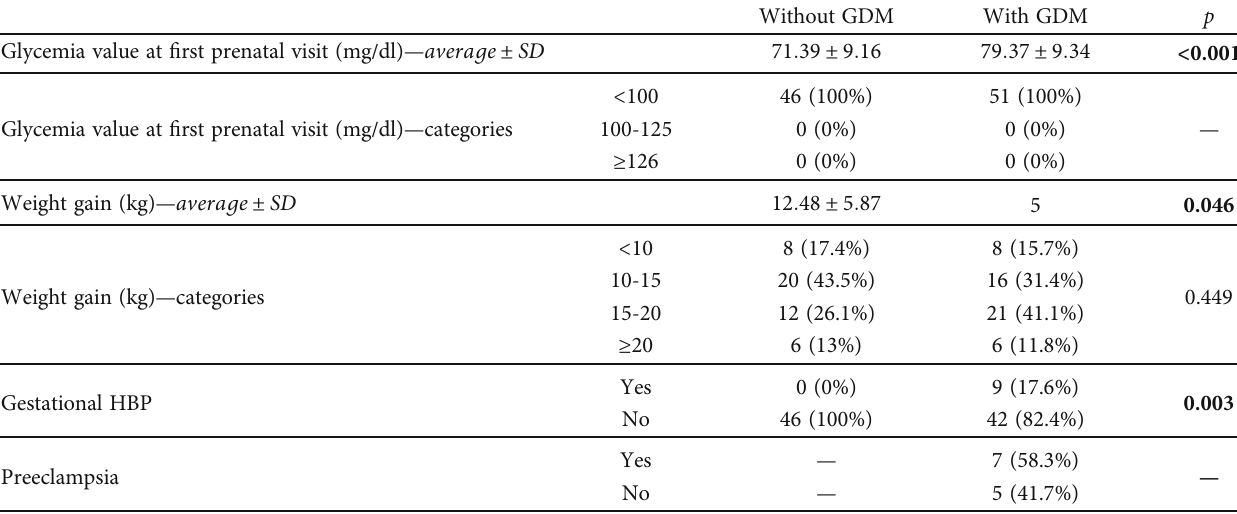
Table 4: Parameters observed during pregnancy. Without GDM With